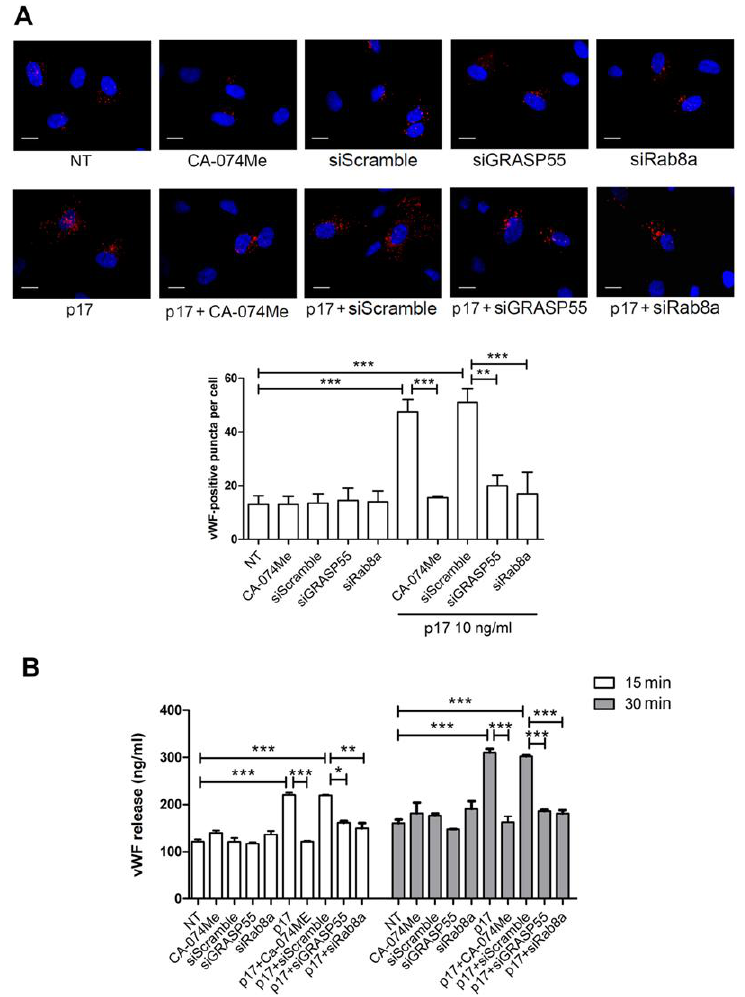
Figure 5. Mechanistic insights into the vWF secretory activity of p17. ( A ) HUVECs were nucleofected with a mCherry-vWF-expressing plasmid in combination or not with siGRASP55, siRab8a or siScramble. Twenty-four h after nucleofection, cells were serum starved for 16 h and then treated with 10 ng / mL of p17. When reported, HUVECs were serum starved in the presence or absence of 50 µ M of CA-074Me (cathepsin- β inhibitor) and then stimulated or not with 10 ng / mL of p17. The images display vWF signals in red and cell nuclei in blue. Scale bar, 10 µ m. Red-positive punctate structures were counted in order to quantify the levels of WPBs. NT indicates not treated cells. Values reported for vWF positive structures are the mean ± SD of 3 independent experiments with similar results. Statistical analysis was performed by one-way ANOVA, and the Bonferroni post-test was used to compare data (** p < 0.01, *** p < 0.001). ( B ) HUVECs were serum starved in the presence or absence of 50 µ M of CA-074Me. In some experiments, HUVECs were nucleofected with siScramble, siGRASP55 or siRab8a and 24 h after nucleofection, cells were serum starved for 16 h. After serum starvation, HUVECs were cultured in complete medium containing or not 10 ng / mL of p17. After 15 and 30 min of culture, supernatants were collected and analyzed by a standard quantitative ELISA. Bars represent the mean ± SD of triplicate samples. Statistical analysis was performed by one-way ANOVA, and the Bonferroni post-test was used to compare data (* p < 0.05, ** p < 0.01, *** p < 0.001). NT indicates not treated cells. Altogether, our data support the key role played by autophagy in the p17-triggered vWF